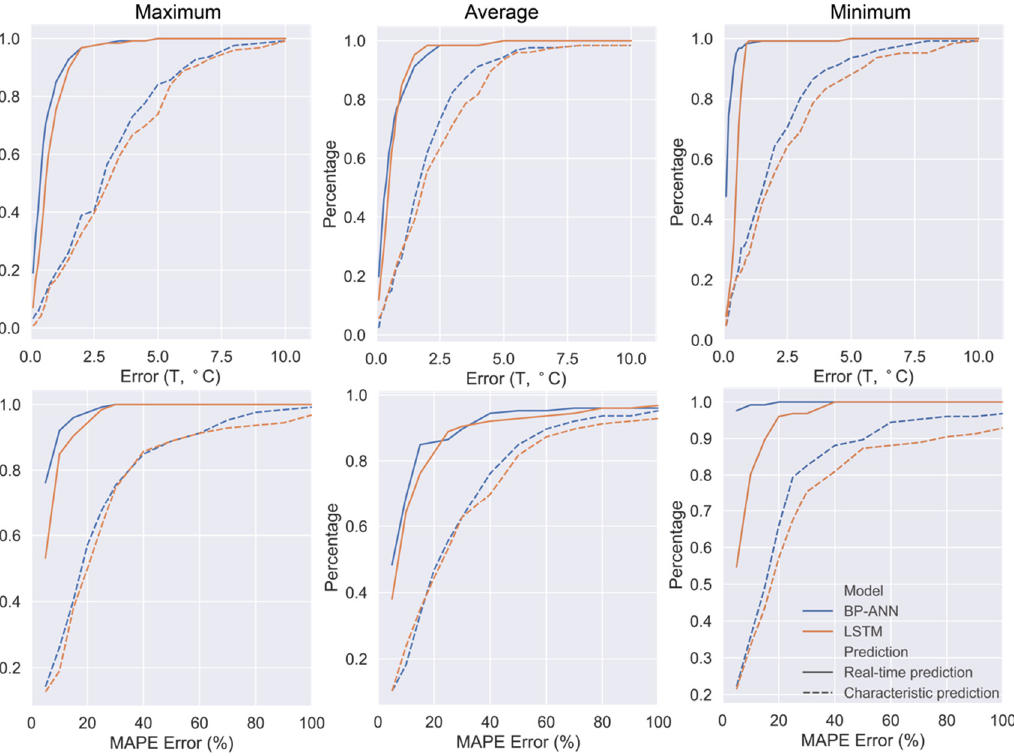
Figure 7. The x-accuracy prediction results of daily temperature using BP-ANN and LSTM tech- niques in Model 1 and 2.